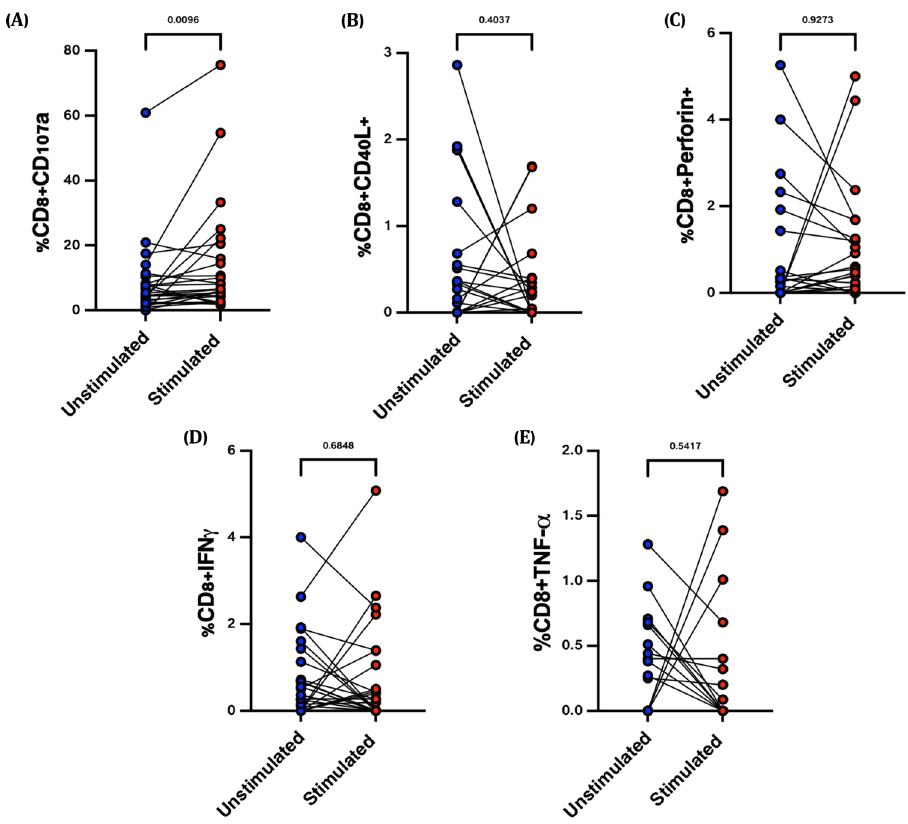
Fig. 4 SARS-CoV-2 spike-speci fi c CD8 + T cell responses ~6 months post-vaccination. Nasal immune cells isolated from ( n = 24) participants, were stimulated with overlapping spike-speci fi c peptides (Red dots) or left unstimulated (Blue dots) for ~16 h. The fi gures show the frequencies of ( A ) CD107a, ( B ) CD40L, ( C ) Perforin, ( D ) IFN- γ and ( E ) TNF antigen-speci fi c CD8 + T cell responses. Wilcoxon matched-pairs signed rank test was used.